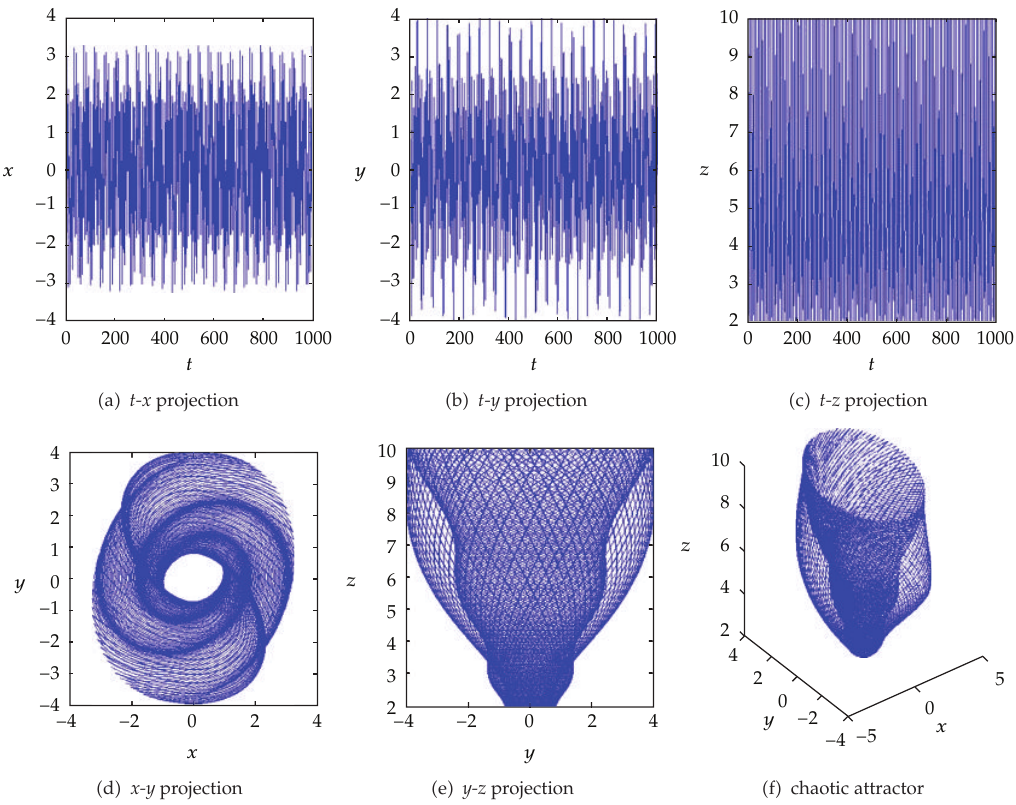
Figure 1: Chaotic attractor generated by one-dimensional space function (cid:4) 2.5 (cid:5)